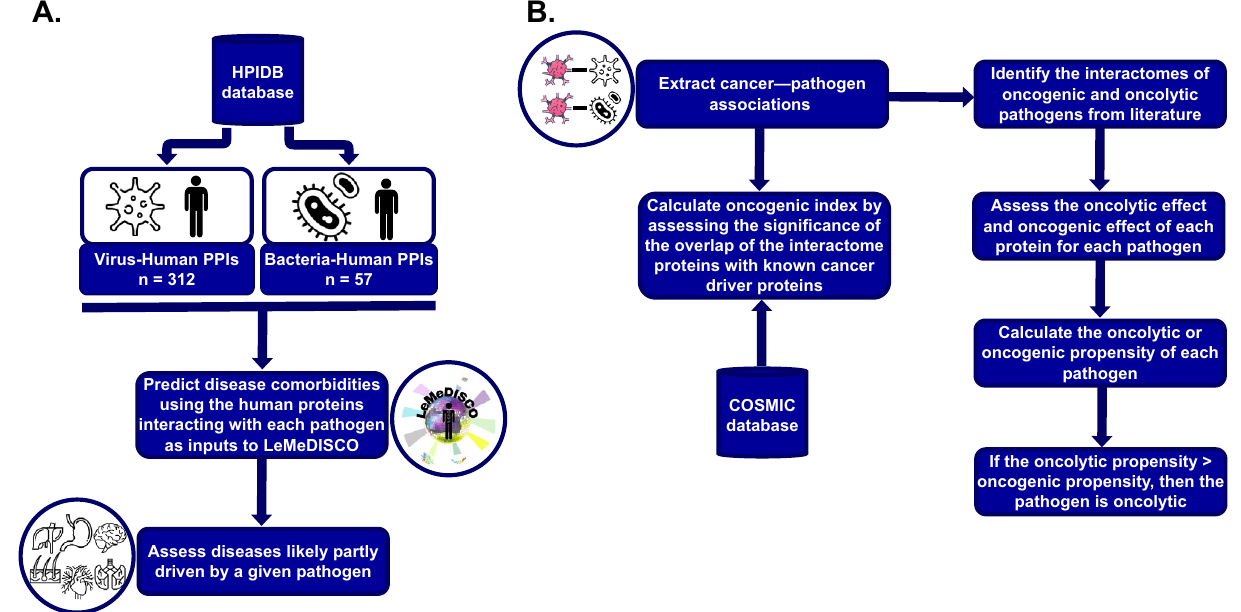
Figure 2. General PHEVIR methodology. ( A ) Comorbidity pipeline; ( B ) Onco-index calculation and oncogenic/oncolytic prediction